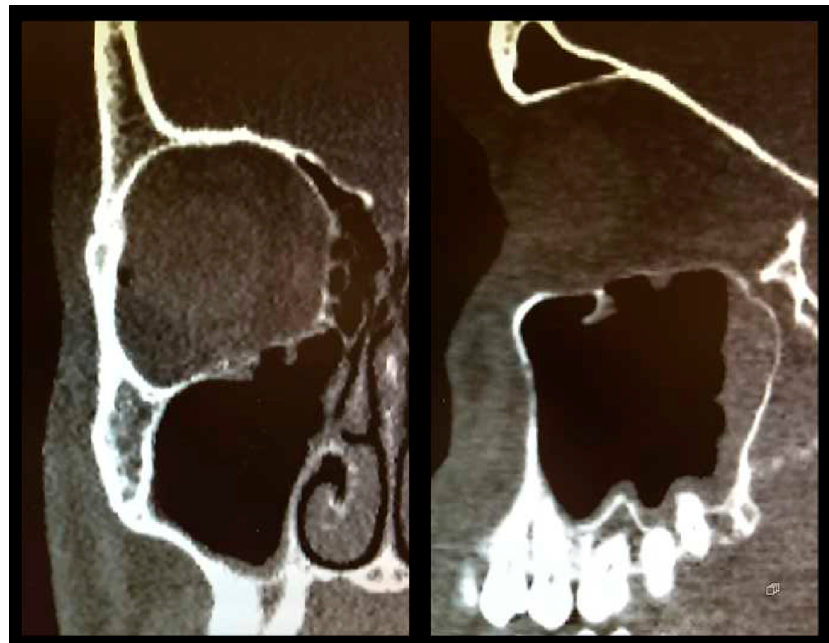
Figure 3. Postoperative CT scan following OFF reduction and placement of Ethisorb ® (( left ) coronal view, ( right ) sagittal view).